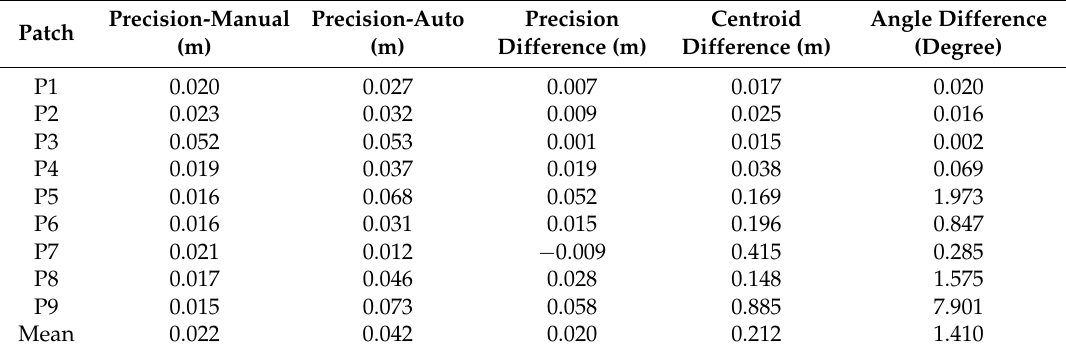
Table 7. Plane fitting precision, plane fitting precision difference, centroid difference, and angle difference values for building #2 (Adaptive cylindrical approach).